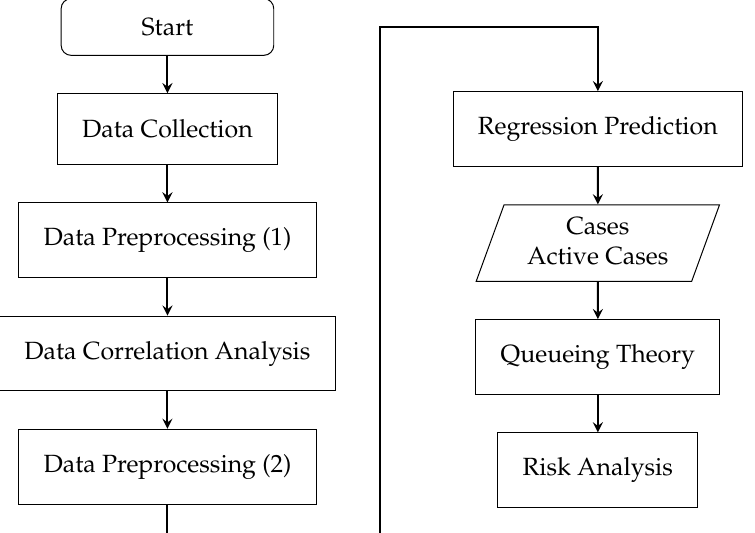
Figure 1. Flow chart of the proposed